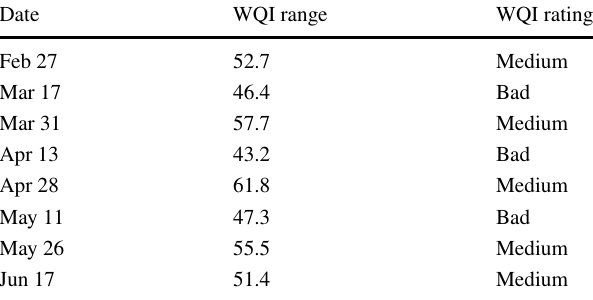
Fig. 5 Water Quality Index (WQI) of incoming and outgoing waters in the pharmaceutical plant from February 27 to June 17, 2013 Table 3 Water Quality Index (WQI) of the outgoing waters in the pharmaceutical plant from February 27 to June 17,